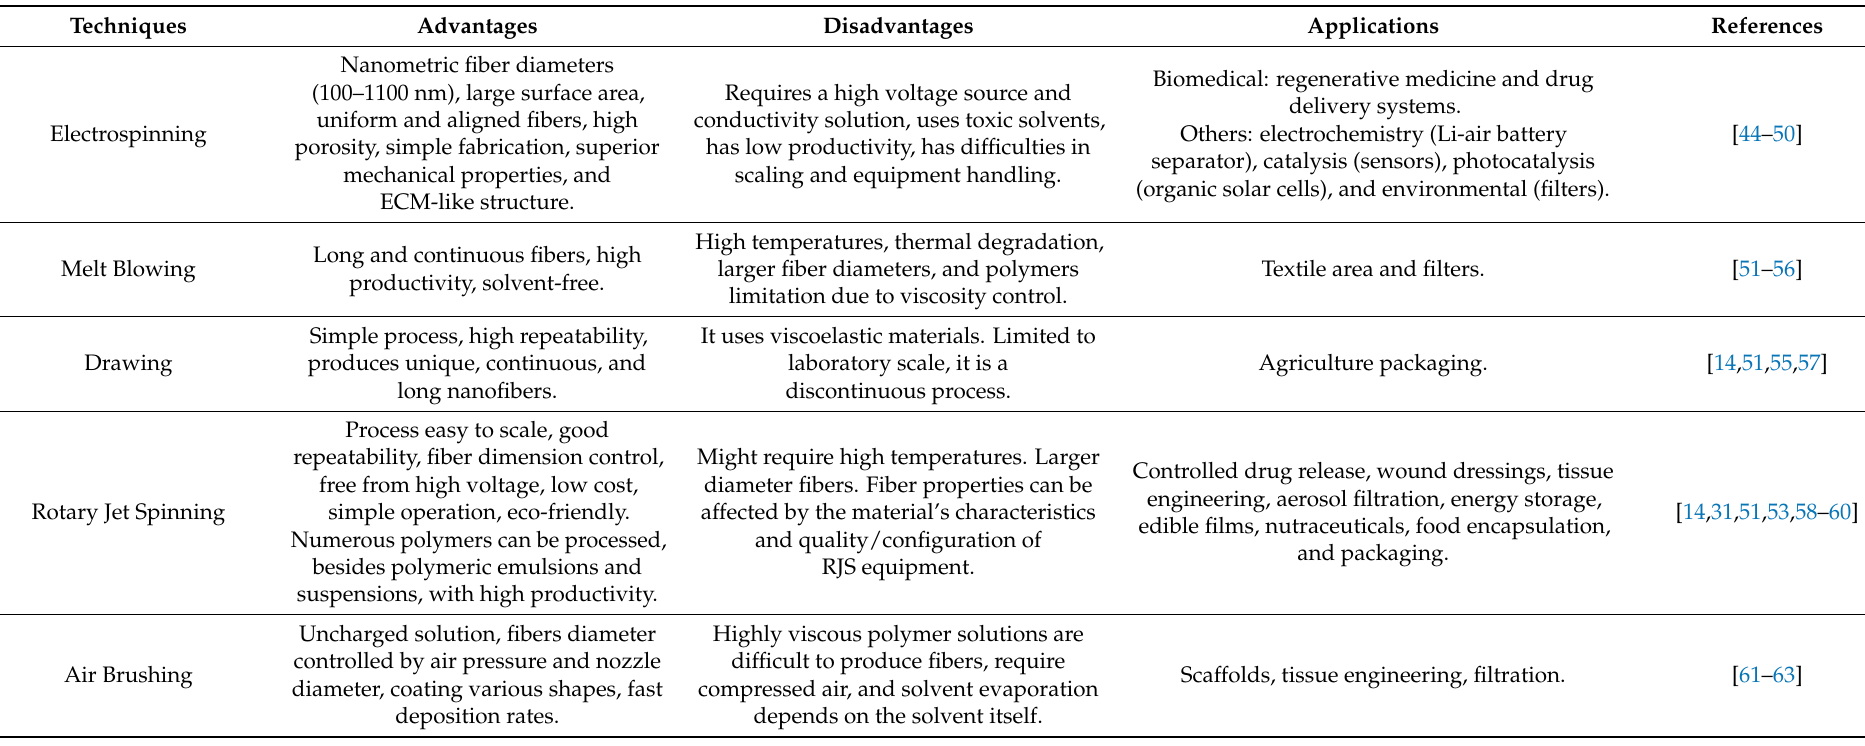
Table 1. Spinning techniques, their main advantages, disadvantages, and